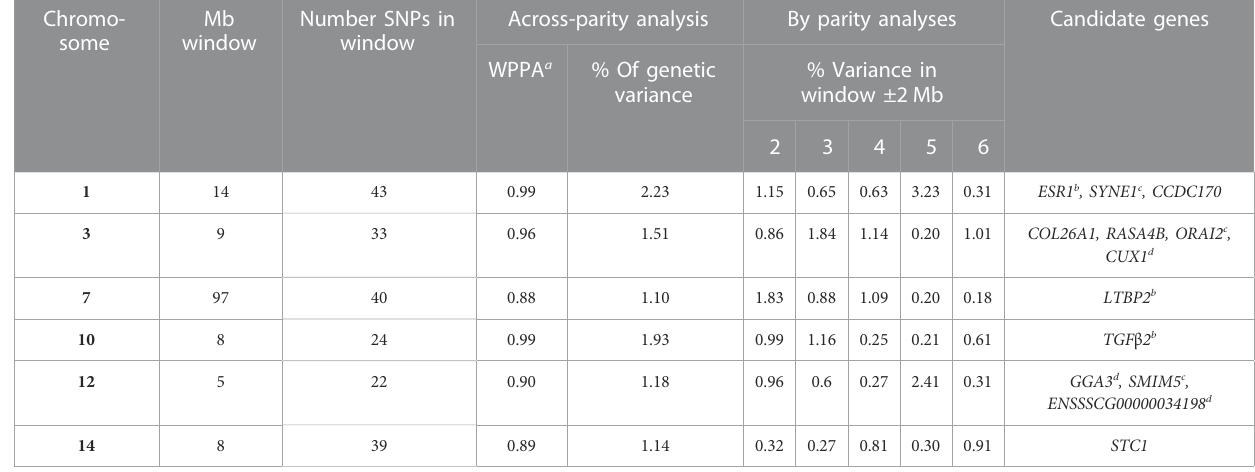
TABLE 2 Genomic regions that explained more than 1% of genetic variance per Mb for culling/death due to pelvic organ prolapse (POP) in the across-parity analyses and the corresponding % of genetic variance explained by that window ±2 Mb in the by-parity analyses, as well as potential candidate genes identi fi ed through annotated gene searches and pCADD